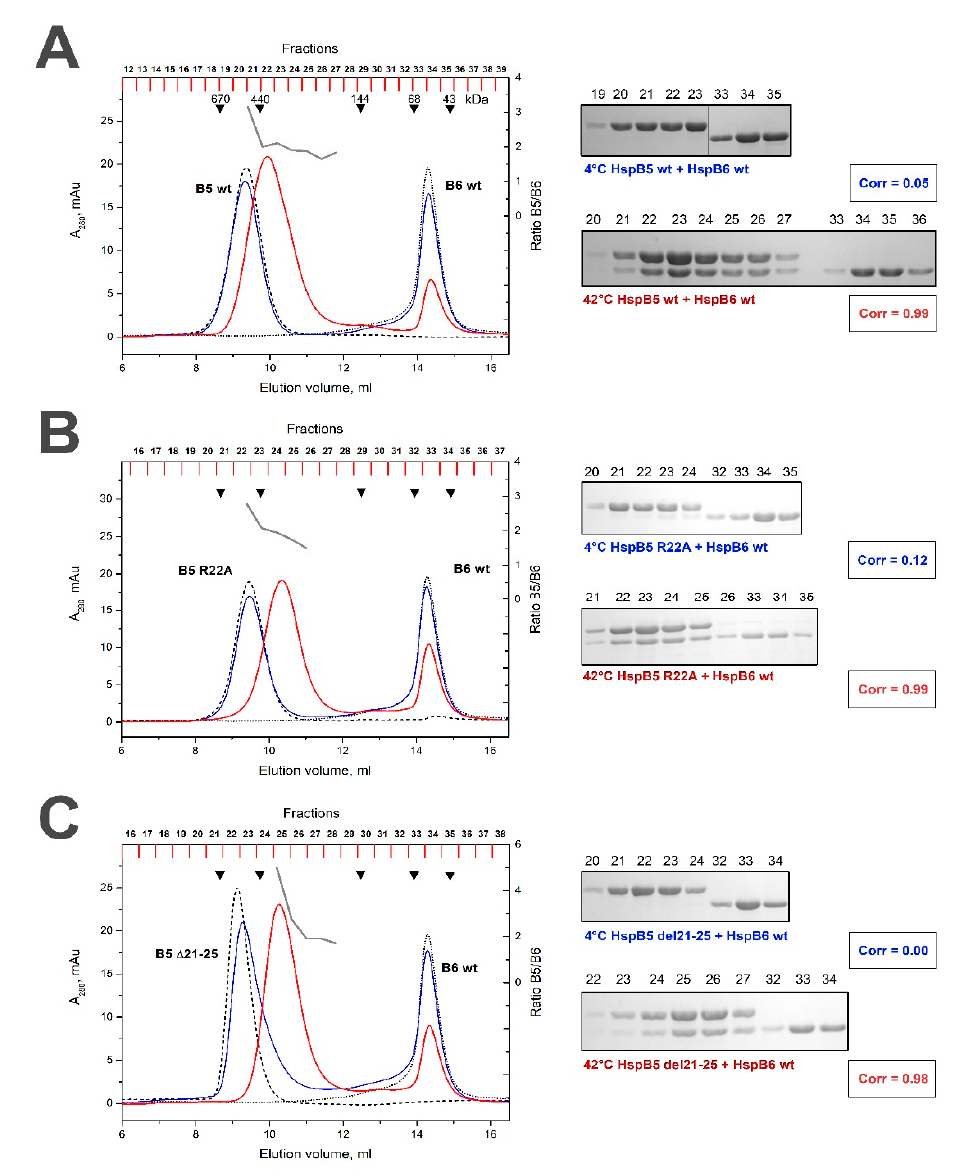
Figure 5. Size-exclusion chromatography of the WT HspB5 ( A ), its R / A ( B ) and ∆ ( C ) mutants and their mixtures with the WT HspB6. The elution profiles of isolated HspB6 are shown as a black dotted line, that of isolated WT HspB5 or its mutants by a black dashed line. The elution profile of the mixture of HspB5 species and WT HspB6 preincubated at low temperature is shown as a solid blue line and that of the corresponding mixture preincubated at elevated temperature is shown as a solid red line. The molar ratio HspB5 / HspB6 (grey solid line) in the corresponding fractions obtained after chromatography of preheated sample is indicated on the right ordinate. The protein composition of the fractions obtained after the chromatography of HspB5 / HspB6 mixture preincubated at low (labeled blue) or high (labeled red) temperature are presented on inserts. The correlation coe ffi cient (Corr) is indicated under each electropherogram. The numbers above tracks correspond to the fractions number. Apparent molecular weights are indicated by